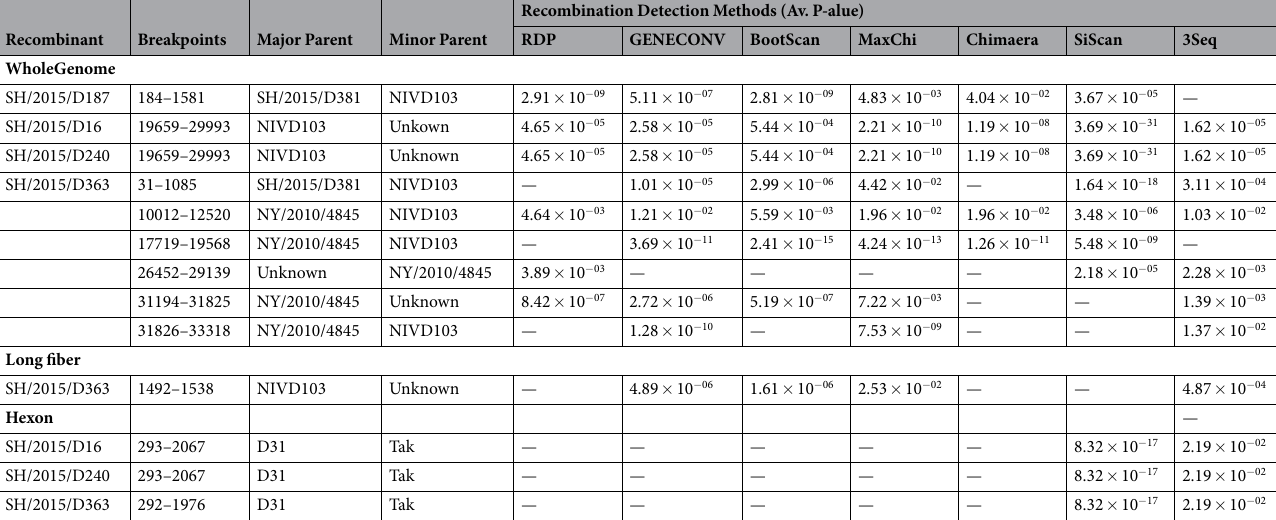
Table 1. Recombination events detected with RDP4 from the alignment of whole genome and individual genes used for tree construction. The average P-value of detection methods are